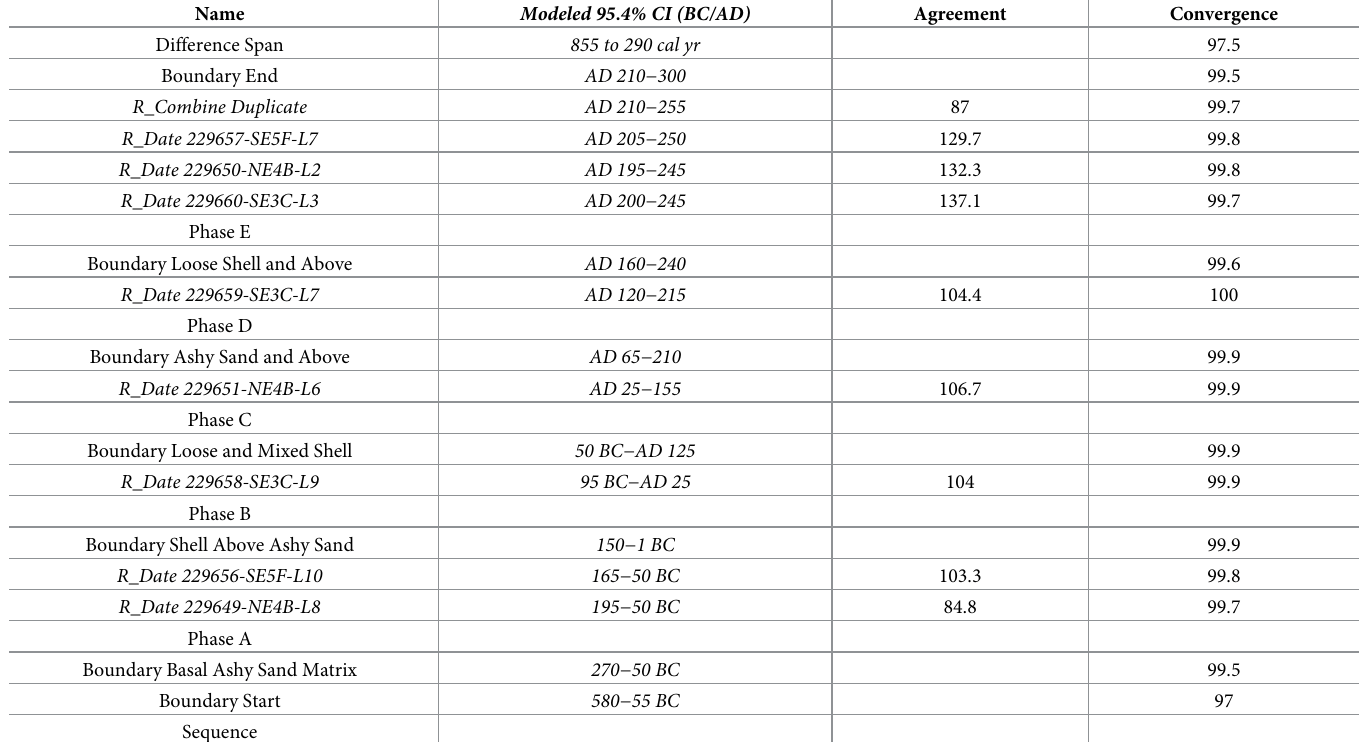
Table 7. The third iteration of the Palmrose chronological modeling, including modeled sequence, 95% probability ranges, and boundaries. Model indices: Amo- del = 124.9 and Aoverall = 127.6.